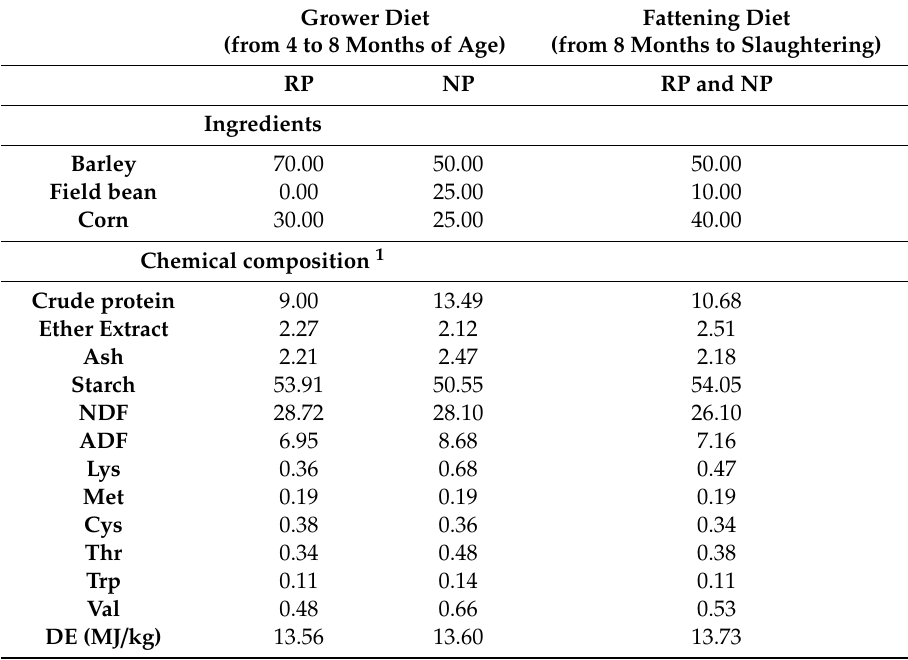
Table 1. Ingredients and chemical composition (% as feed) of the experimental